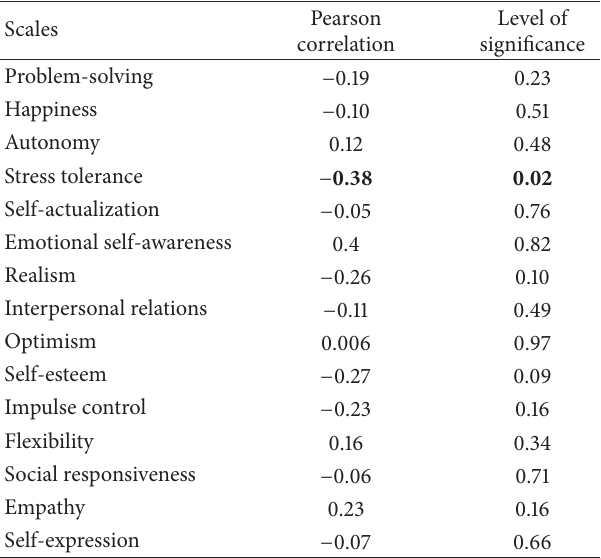
Table 3: Pearson correlation coefficient between components of emotional intelligence and the age of alcohol consumption in alcohol dependent individuals ( n =